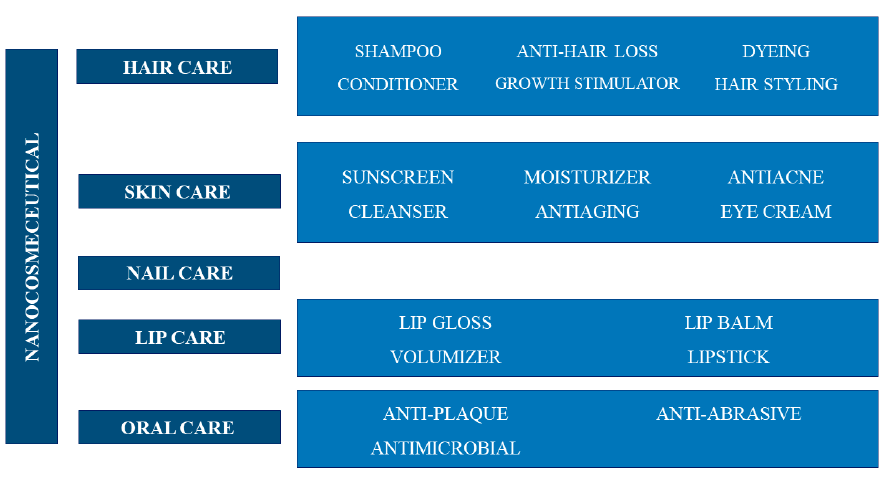
Figure 5. Nanocosmeceutical applications in personal care.